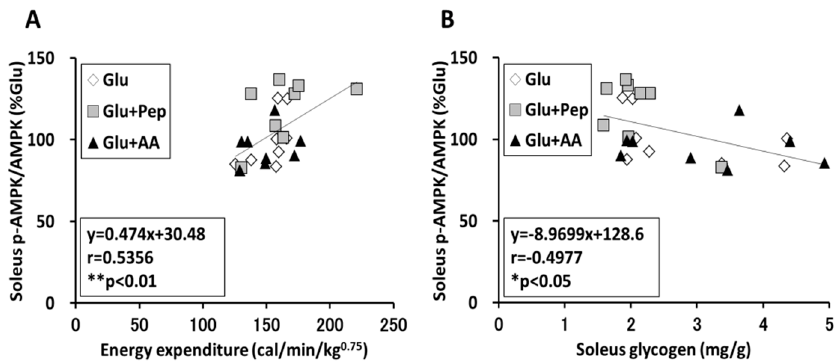
Figure 8. Correlation of energy expenditure, muscle glycogen content, and AMPK phosphorylation state in the soleus muscle. ( A ) Correlation between energy expenditure and AMPK phosphorylation state in the soleus muscle; ( B ) Correlation between muscle glycogen content and AMPK phosphorylation state in the soleus muscle. Values are presented as mean ± SEM.